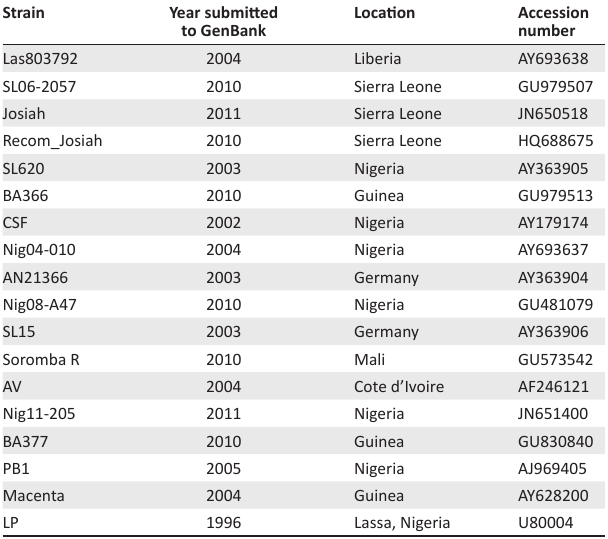
TABLE 2: Lassa fever viral strains used for homology and phylogenetic analysis of Ghana case strains,